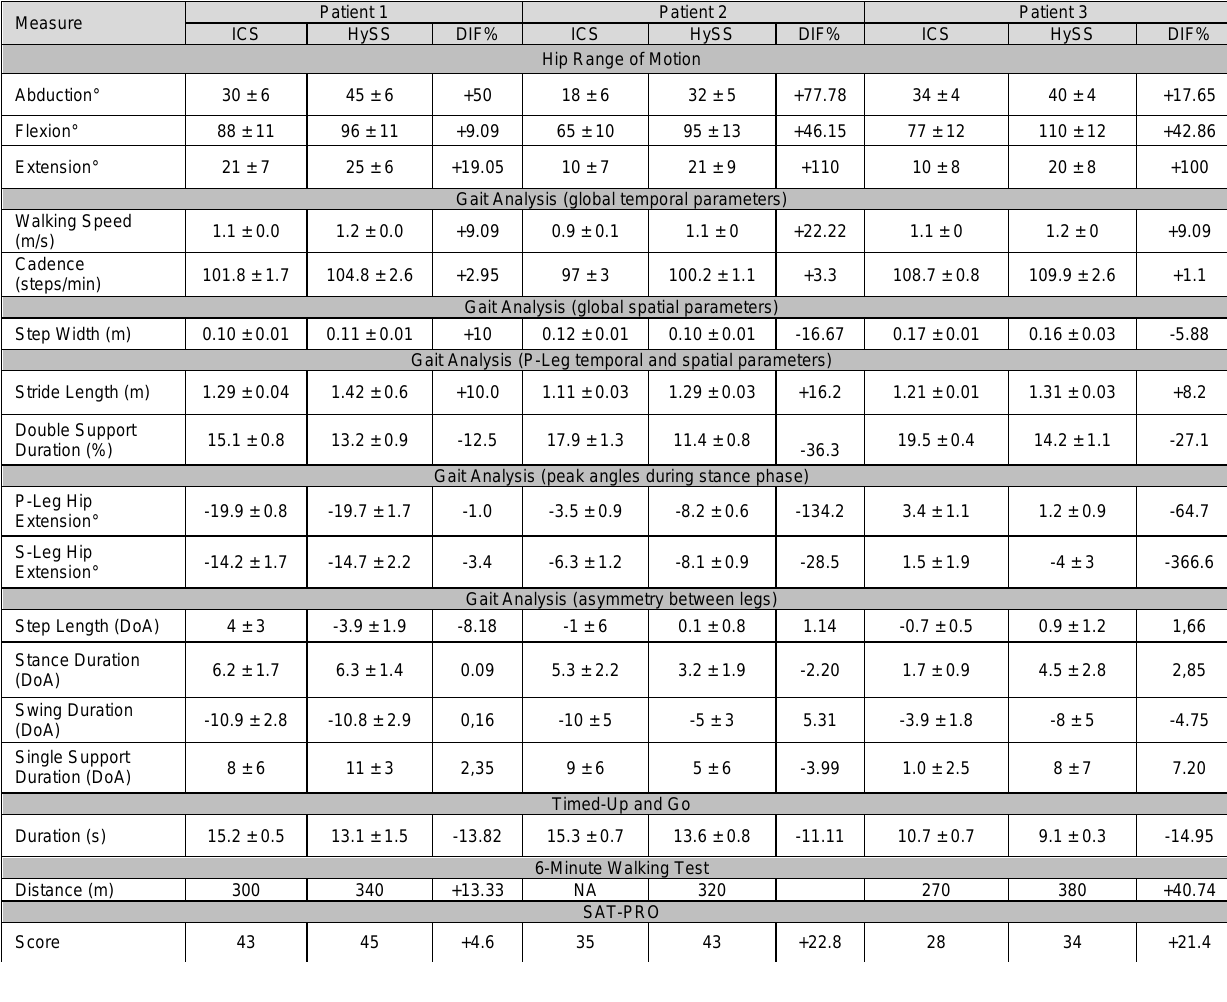
Table 2: Results obtained for each participant with both sockets. The difference (DIF%) is expressed as percentage variation. ICS: Ischial Containment Socket. HySS: Hybrid Subischial Socket. DoA: Degree of Asymmetry.